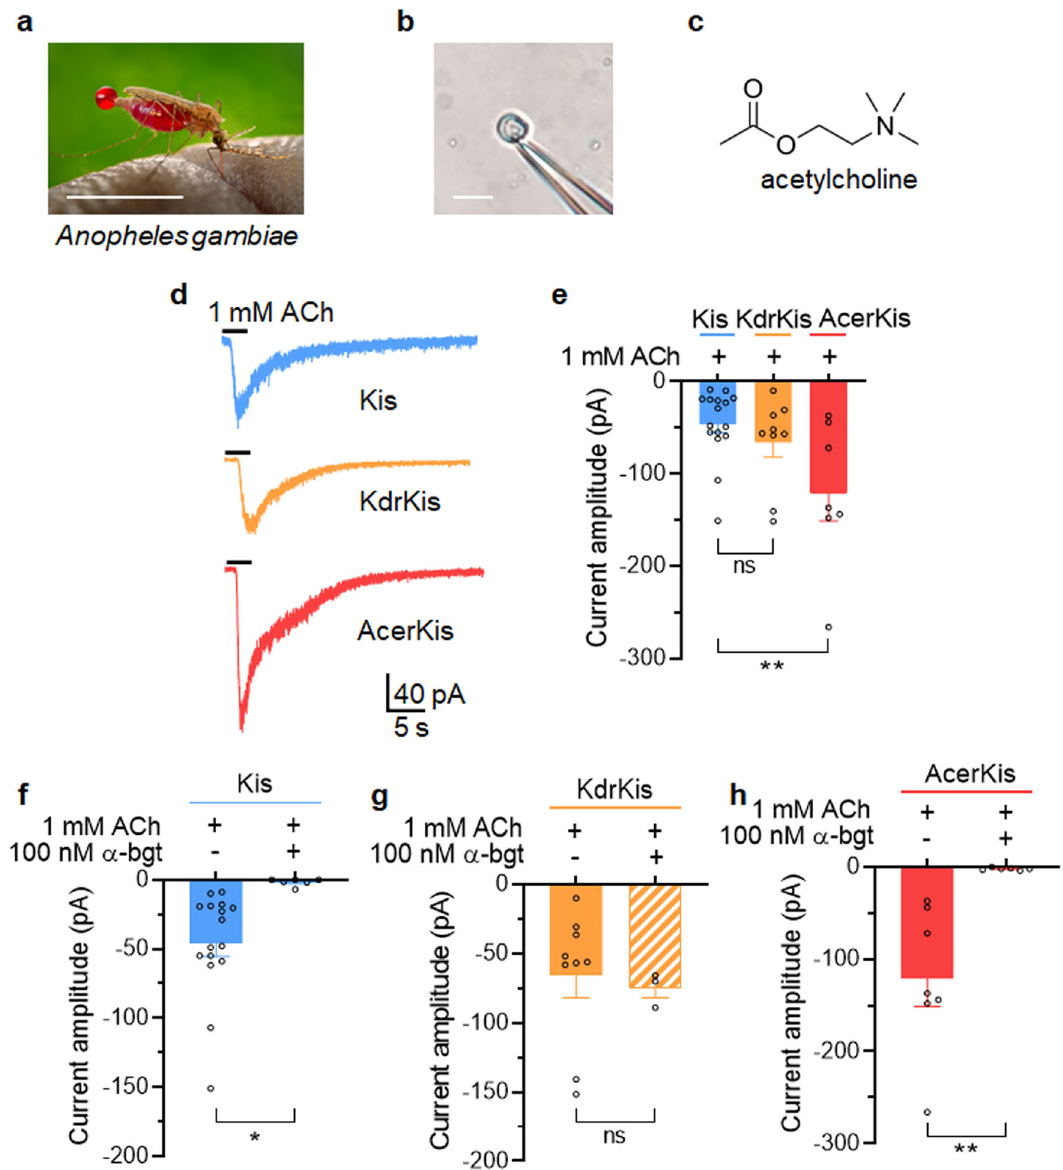
Fig. 1 Acetylcholine induces transient inward currents in isolated neurons from Anopheles gambiae , Kis, AcerKis and KdrKis strains. a Photograph of the lateral view of a female Anopheles gambiae . b Light micrograph of the whole cell patch-clamp technique adapted on the isolated adult mosquito neuron cell body. c The chemical structure of the natural neurotransmitter acetylcholine. d Typical examples of steady-state recordings of acetylcholine (ACh)- induced inward currents obtained in whole-cell voltage-clamp mode at a steady-state holding potential of − 50 mV. Pulse of ACh (1 mM, 3 s in duration) was applied onto the isolated neuron cell body from three Anopheles gambiae strains, Kis, KdrKis and AcerKis, as indicated below each current trace. e Histogram summarizing the ACh-induced current amplitudes recorded at a holding potential of − 50 mV in three strains of Anopheles gambiae isolated neurons indicated above each bar. Bars represent mean ± S.E.M. ( n = 7 – 16); Statistical test used was Student unpaired t -test, ** p < 0.01; ns, non-signi fi cant. f – h Comparative histograms illustrating the effect of the nicotinic receptor antagonist α -bungarotoxin ( α -bgt; 100 nM) on the ACh-induced inward current amplitudes, recorded at a holding potential of − 50 mV in isolated neurons from mosquito strains Kis ( f ), KdrKis ( g ) and Acerkis ( h ). Bars represent mean ± S.E.M. ( n = 4 – 6); Statistical test used was Student unpaired t -test, ** p < 0.01; * p < 0.05; ns, non-signi fi cant. Scale bar 1 cm ( a ) and 10 µ m ( b ). The number of experiments ( n ) are biologically independent samples. The image presented in a is in the public domain and thus free of any copyright restrictions (CDC/James Gathany,